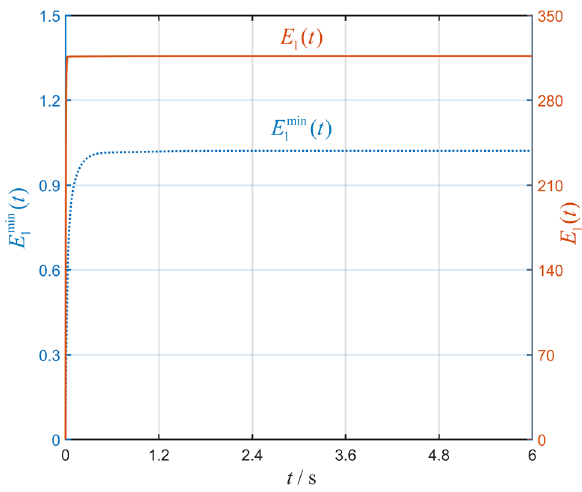
min t ) and E 1 ( t ) 1 (